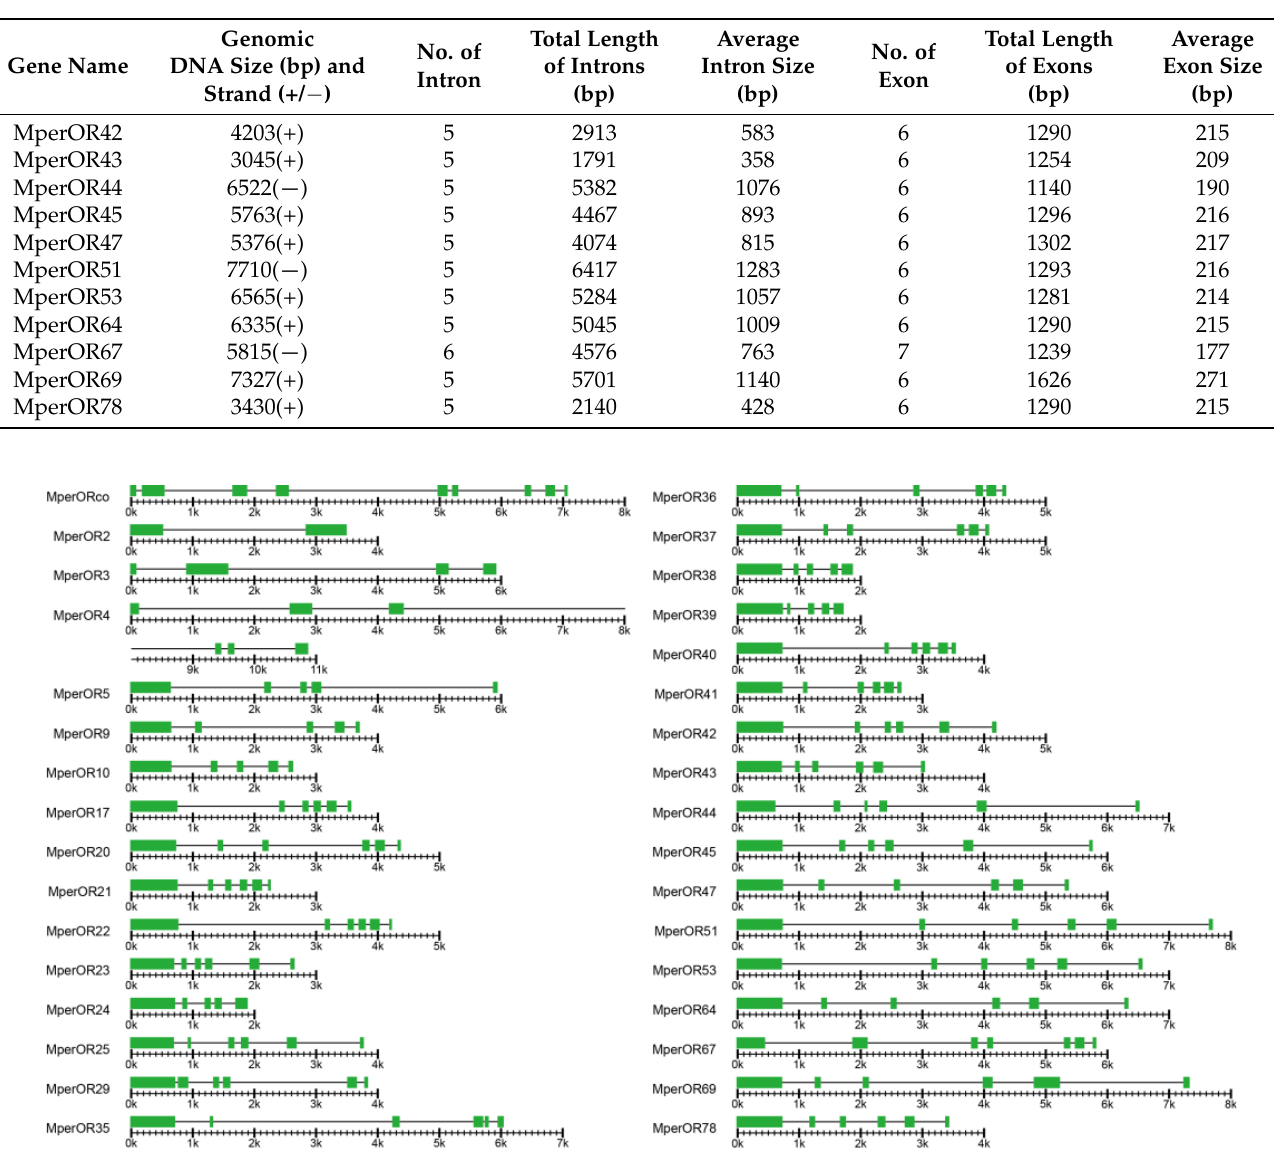
Figure 2. Genomic structure of M. persicae OR genes. The green rectangles and hairlines between two green rectangles represent the exons and introns, respectively. The length has been shown to scale with a scale bar under each M. persicae OR gene; every minor mark represents 100 bp.